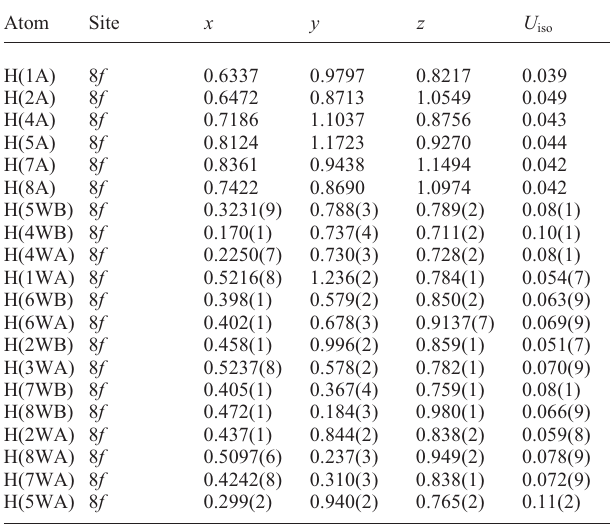
Table 2. Atomic coordinates and displacement parameters (in Å 2 )